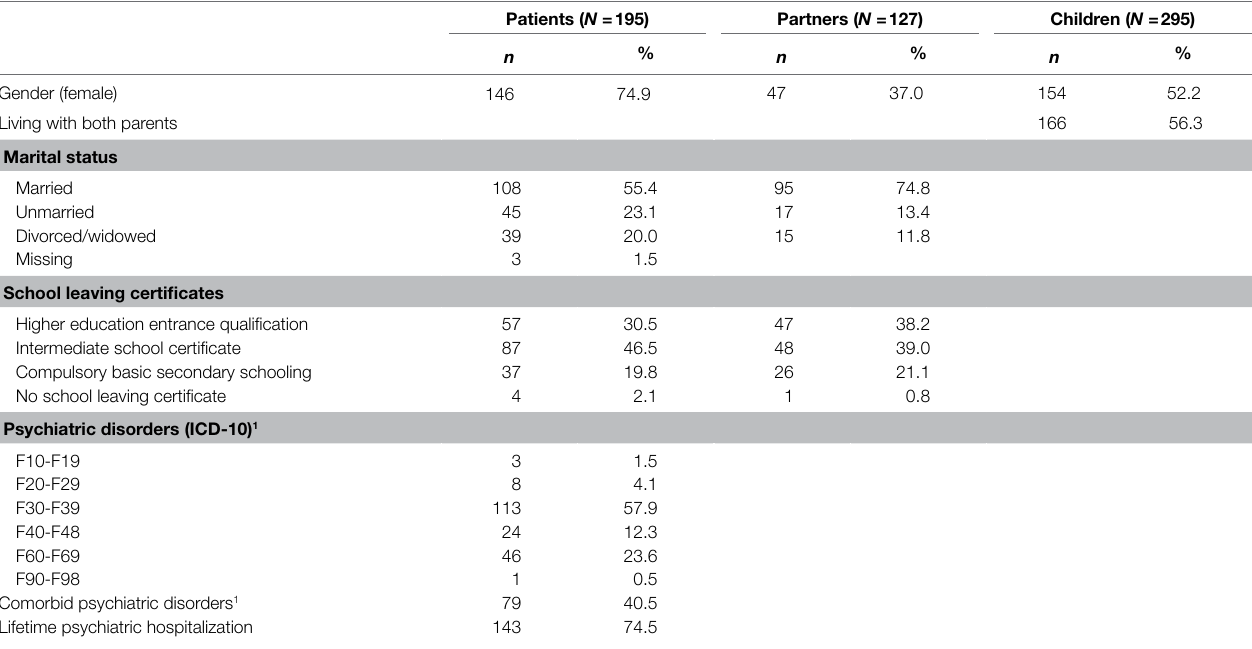
TABLE 1 | Characteristics of patients, partners, and